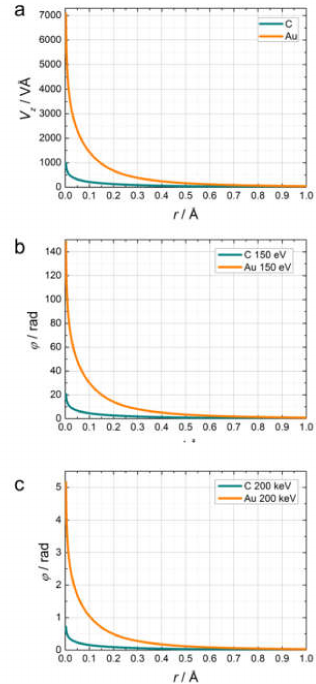
Figure 5. Calculated projected potentials for C and Au atoms ( a ), relative phase shifts introduced by C and Au atoms when probed with 150 eV ( b ), and 200 keV ( c )